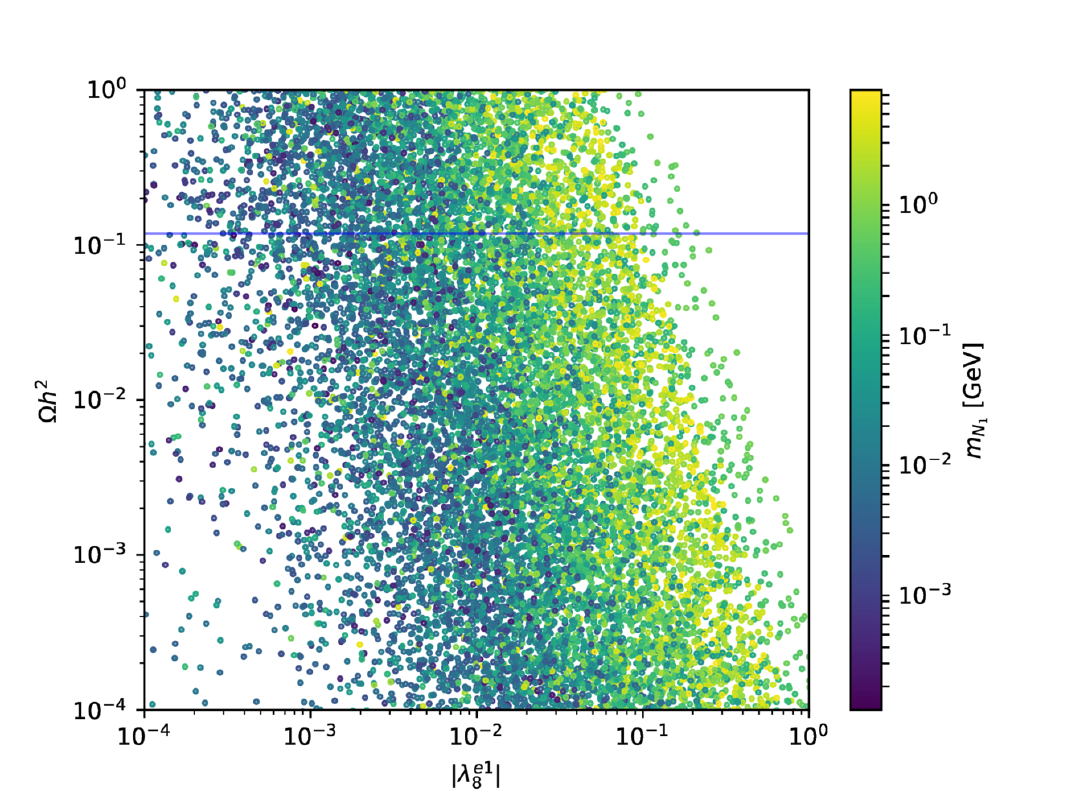
Figure 2 . The relic density (cid:10) h 2 obtained in the SLIM model with right-handed neutrino DM versus the absolute value of its coupling to electrons and electron neutrinos (cid:21) e 1 measured by Planck [2] is shown as a blue horizontal band, and the lightest Majorana neutrino mass m N is given on a colour 1